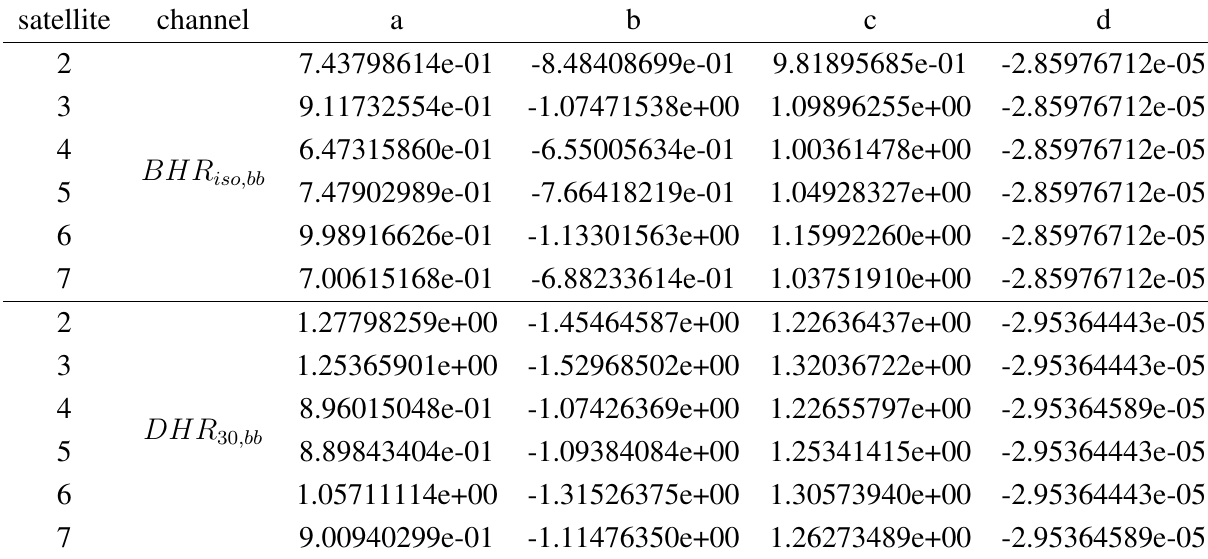
Table 2. Estimated spectral conversion coefficients for the conversion of Meteosat spectral albedo to the broadband albedo using equation (1) of the